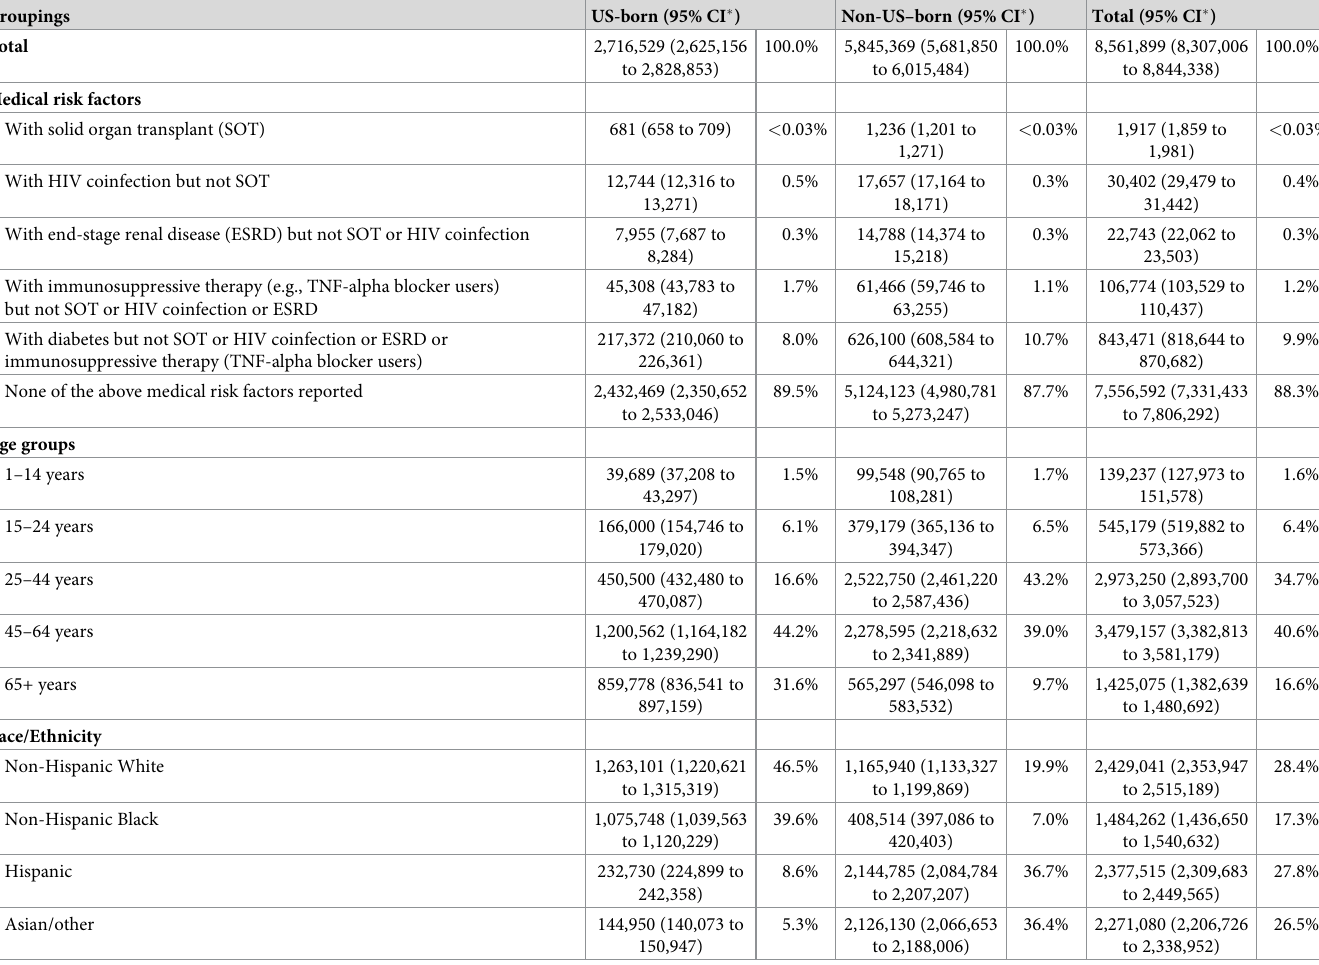
Table 2. Estimated number of people living with latent tuberculosis infection in the United States in 2015, by medical risk factors and demographic characteristics, stratified by nativity.